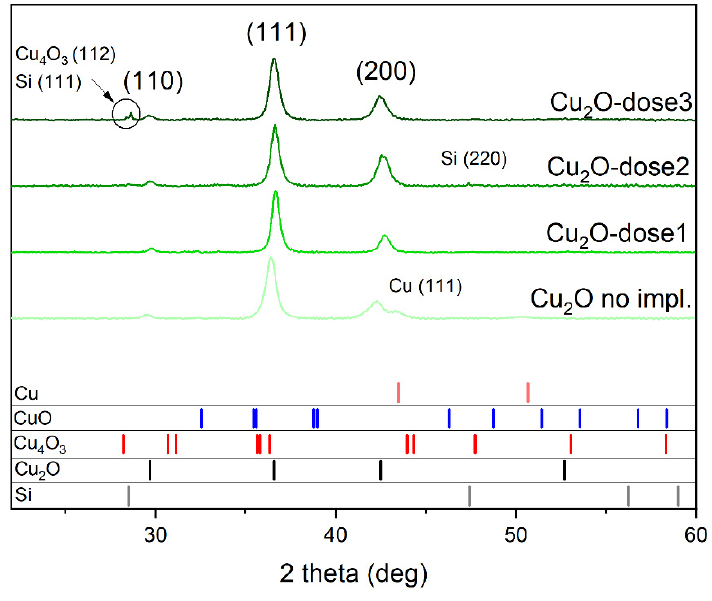
Figure 2. X-ray diffractograms of non-implanted and implanted Cu 2 O samples. In the lower part of the graph, reference patterns of copper, copper oxides, and substrate material are shown.